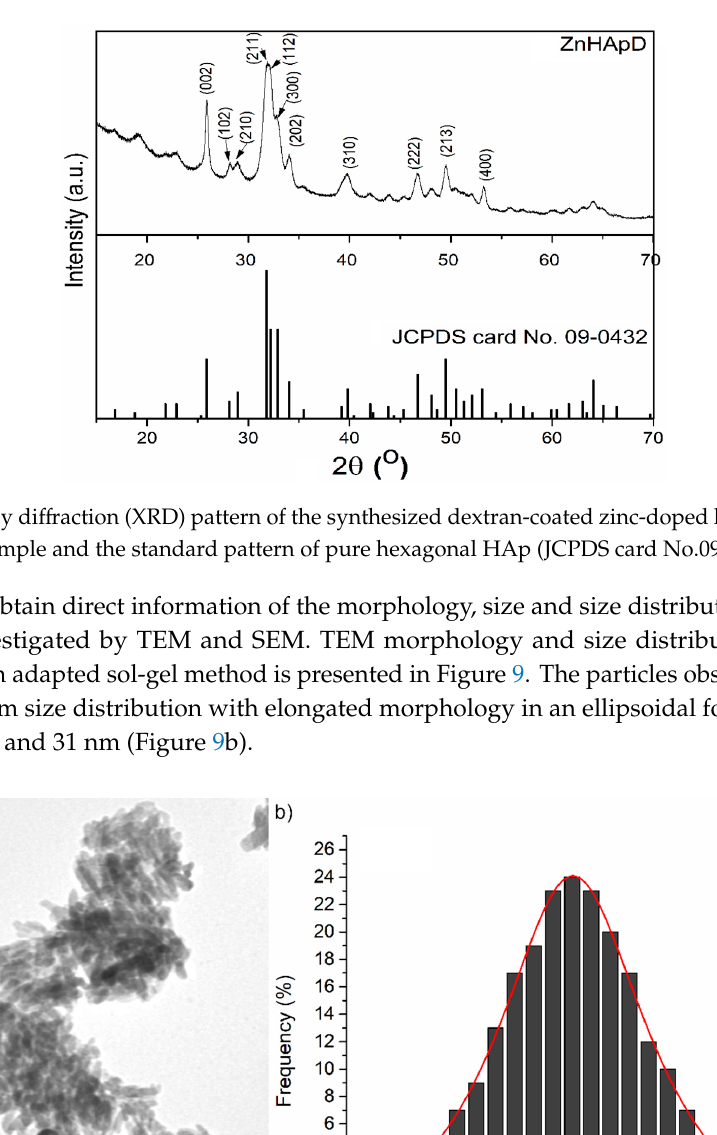
Figure 10. Representative image of ZnHApD powders ( a ) and size distributions ( b ) obtained by scanning electron microscopy (SEM). Figure 11. The energy dispersive spectroscopy (EDX) mappings of of ZnHApD powders. Different concentrations (62.5, 125, 250 and 500 μ g/mL) of the ZnHApD solution were added to HEK-293 cells and analyzed after 24 and 48 hours, respectively. The results obtained are shown in Figure 12. As can be seen in Figure 12, the ZnHApD nanoparticles exhibited a non-toxic activity against HEK-293 cells at all concentrations analyzed. After 24 h, cell viability was 90–98%. At a concentration of 500 μ g/mL, the cell viability was 90%, while in case of lower dosages (62.5 and 125 μ g/mL) the cell viability was 98%. A 95% cell viability was observed at the concentration of 250 μ g/mL. After an 48h incubation of HEK-293 cells with different concentrations of ZnHApD solution the results concerning the cell viability were similar to those obtained at 24 h for concentrations of